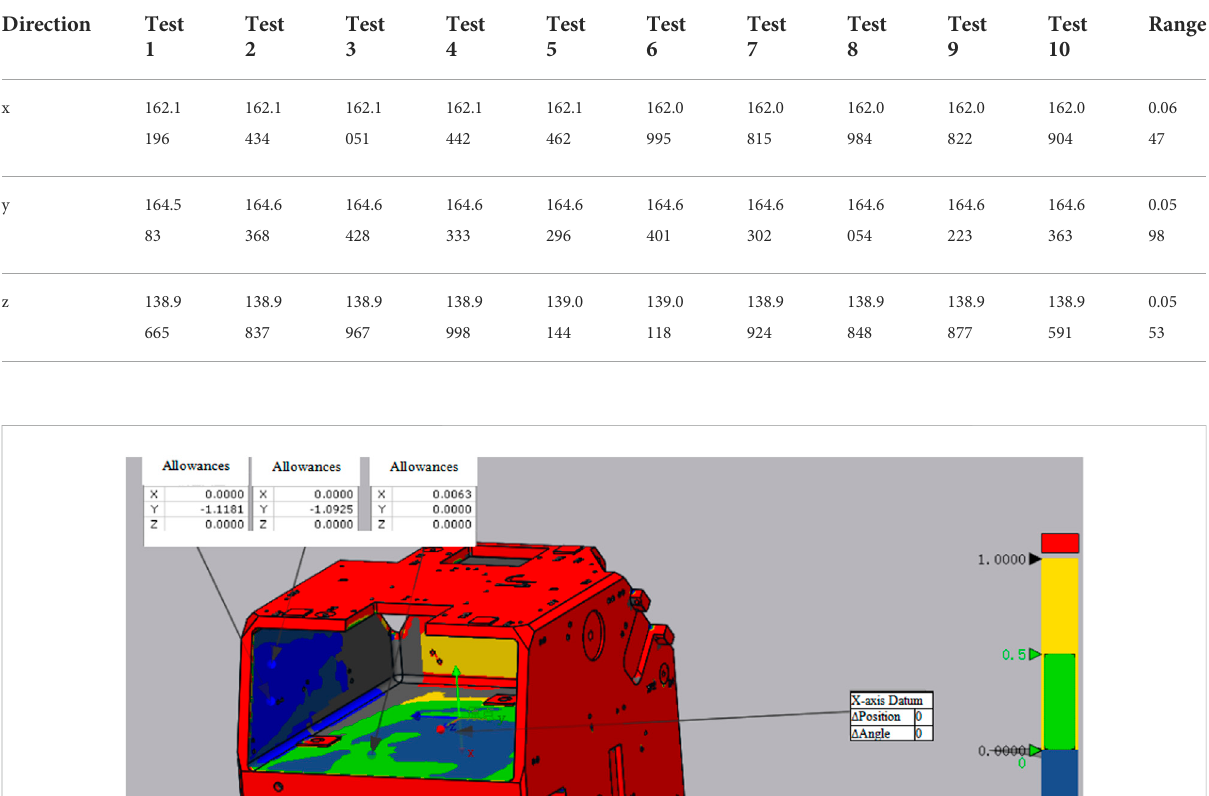
TABLE 6 The tested casting.